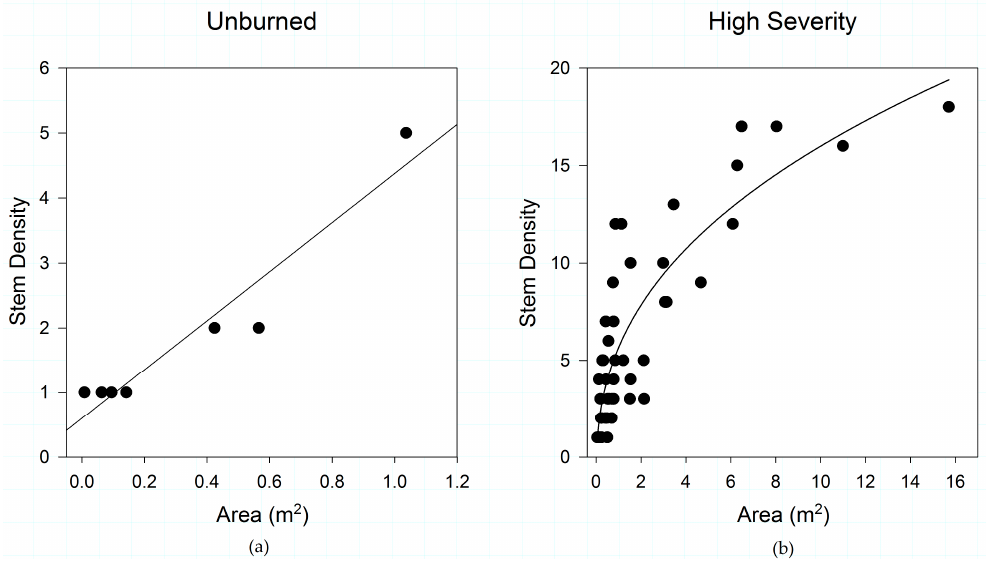
Figure 3. Fire severity effects on obligate seeding species across fire severities in: ( a ) unburned plots; and ( b ) high severity plots, in the study area. Obligate sprouting species show no pattern in shrub structure in any fire severity class, but obligate seeders growing in unburned, moderate-severity, and high-severity burned areas demonstrate characteristic patterns in shrub patch